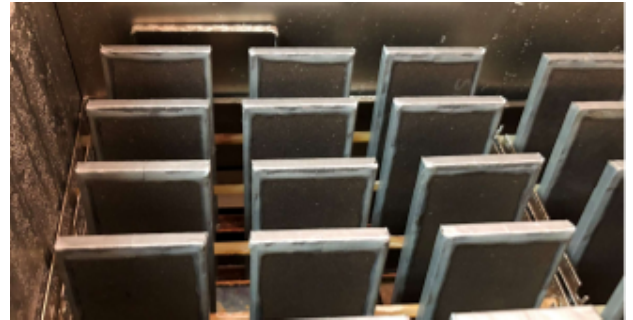
Figure 3. Organization of steel plates in